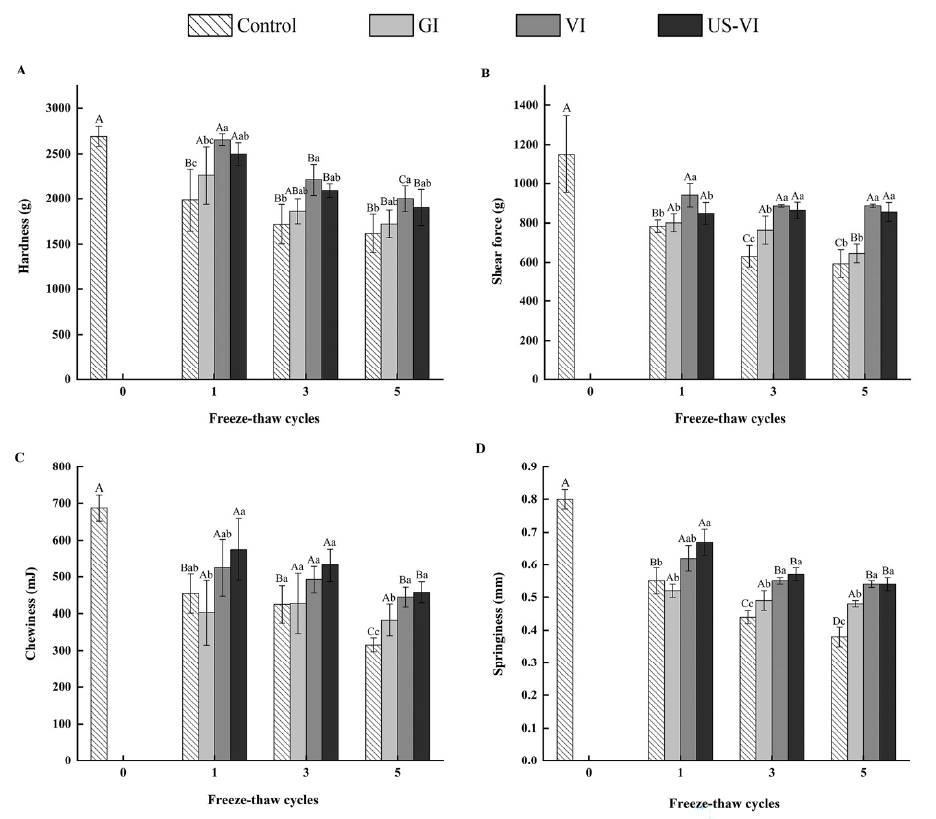
Figure 3. Changes in the texture of the scallop adductor muscle induced by freeze–thaw cycles. (( A ) Hardness, ( B ) shear force, ( C ) chewiness, ( D ) springiness). “A–D” indicated the difference in different number of FTCs ( p < 0.05). “a–d” indicated the difference in samples with different pretreatment methods ( p <